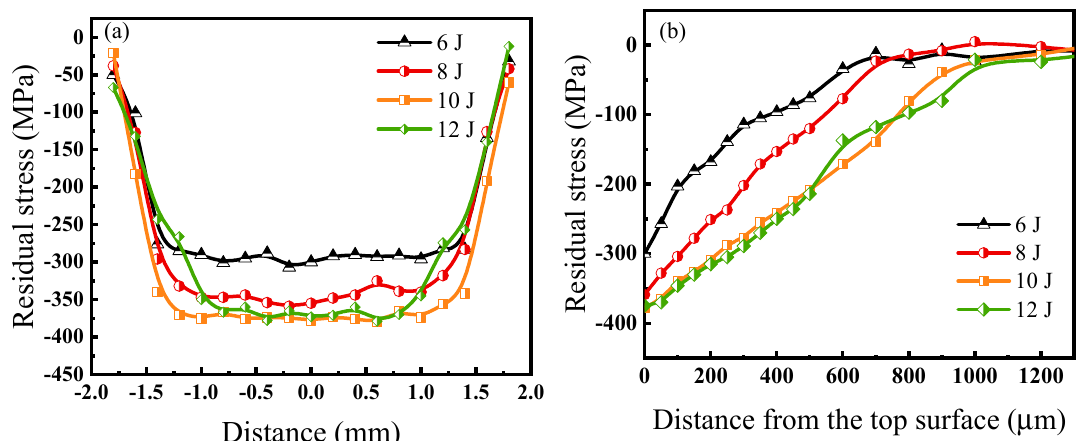
Figure 11. Residual stress distribution in the surface layer of the specimen at different pulse energies ( a ) Surface residual stress distribution ( b ) Depth direction residual stress distribution.